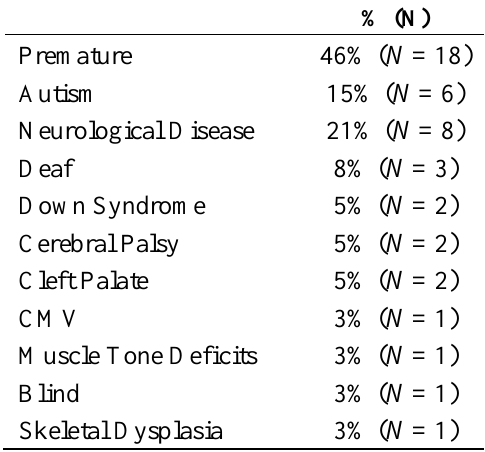
Table 2. Child Diagnoses at Study Entry ( N =